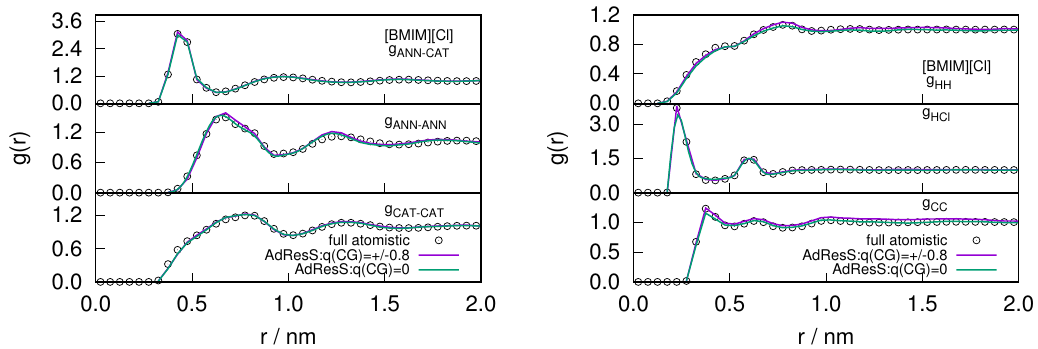
Figure 5. The variation of intermolecular ( left ) and intramolecular ( right ) radial distribution profile calculated in the atomistic region of AdResS for (charged/neutral) coarse-grained models and compared with the corresponding quantity calculated in the equivalent region of a full atomistic simulation for the [ BMIM ][ Cl ] − system. The center of mass of the cations and anions are represented as CAT, ANN or Cl respectively. CAA is the carbon, of the methyl group attached to the imidazolium ring and H is the hydrogen that is present in between the 1-methyl and 3-butyl chain of the cations.